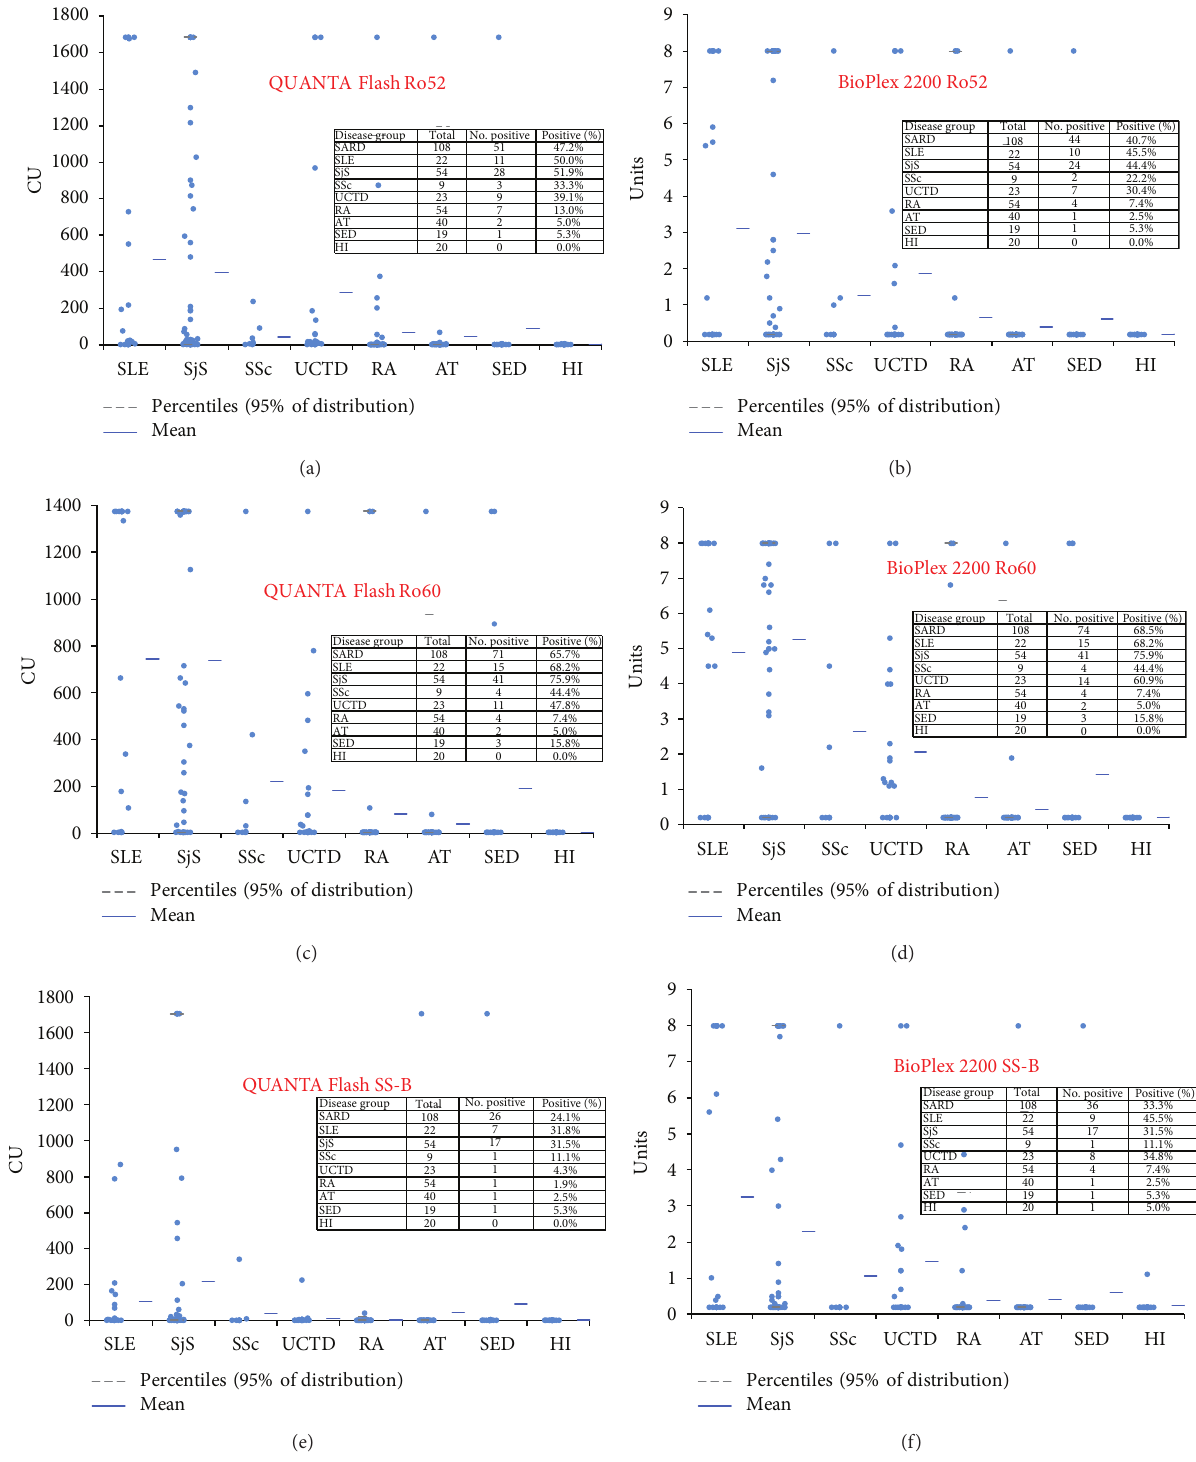
Figure 2: Prevalence and titers of anti-Ro60, Ro52, and SS-B antibodies. Results for anti-Ro60 are shown in (a) and (b), for anti-Ro52 in (c) and (d), and for anti-SS-B antibodies in (e) and (f). AT: Atopic dermatitis, HI: healthy individuals, RA: rheumatoid arthritis, SED: suspected eye disease, SLE: systemic lupus erythematosus, SjS: Sj¨ogren’s syndrome, SSc: systemic sclerosis, UCTD: undifferentiated connective tissue